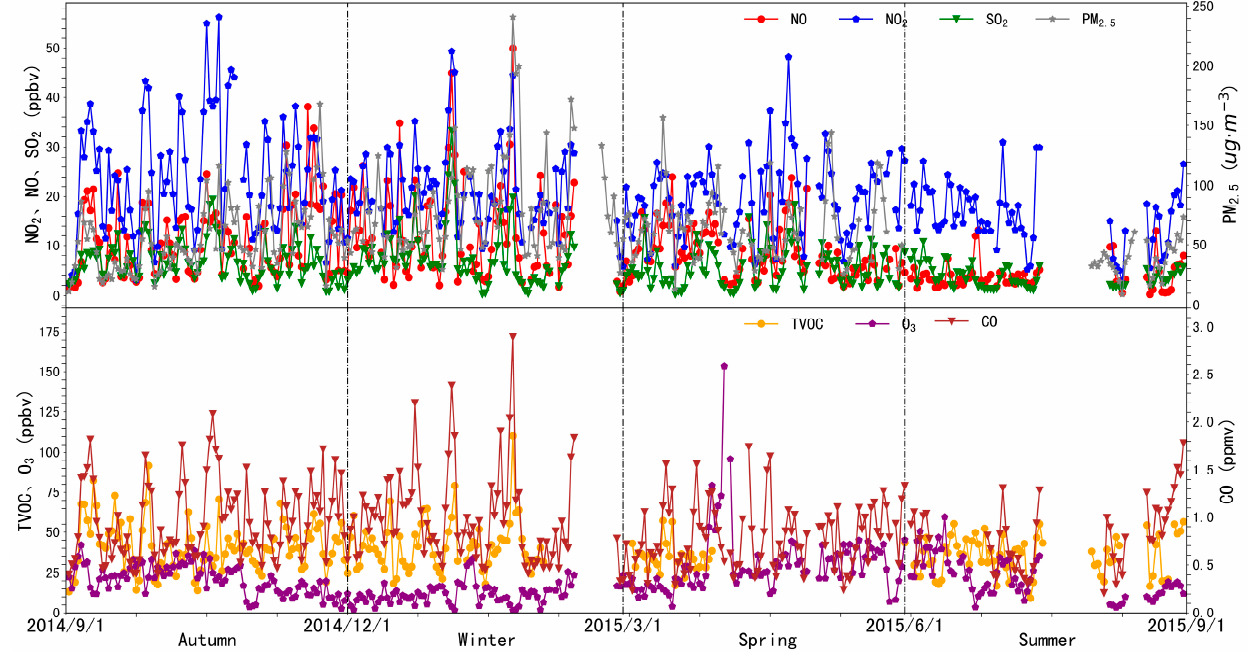
Figure 3. The daily variations in the different pollutant concentrations.